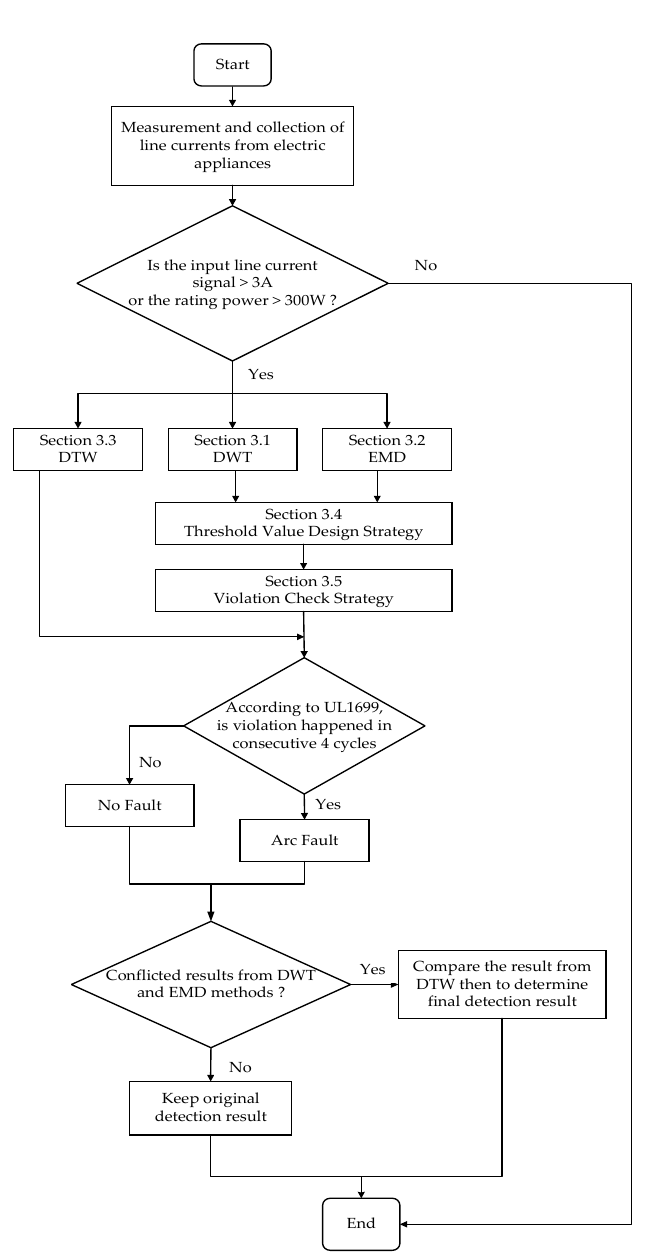
Figure 7. Flowchart of the proposed hybrid approach.